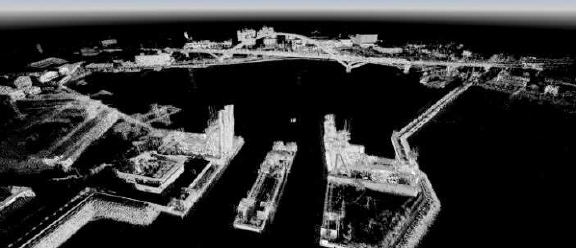
Figure 8. Recognition of coastal area in point cloud by